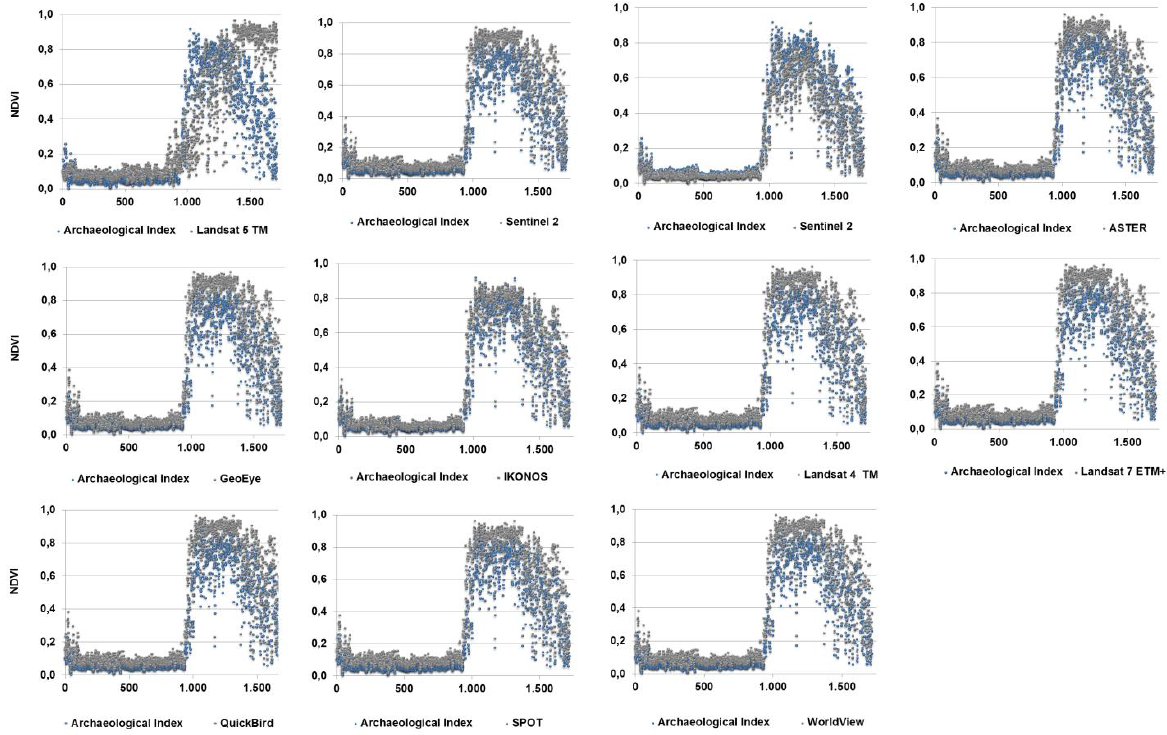
Figure 4. NDVI values as retrieved from the different sensors mentioned in the study compared with the Normalized Archaeological